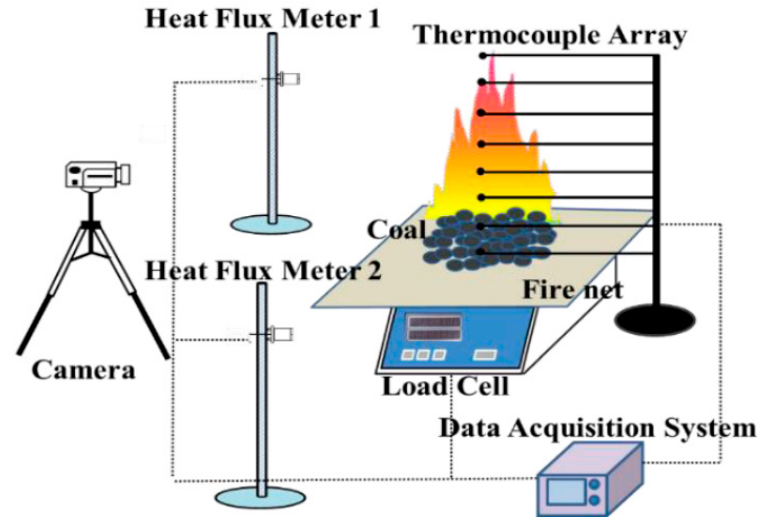
Figure 1. The testing apparatus for fl ame combustion of coal.